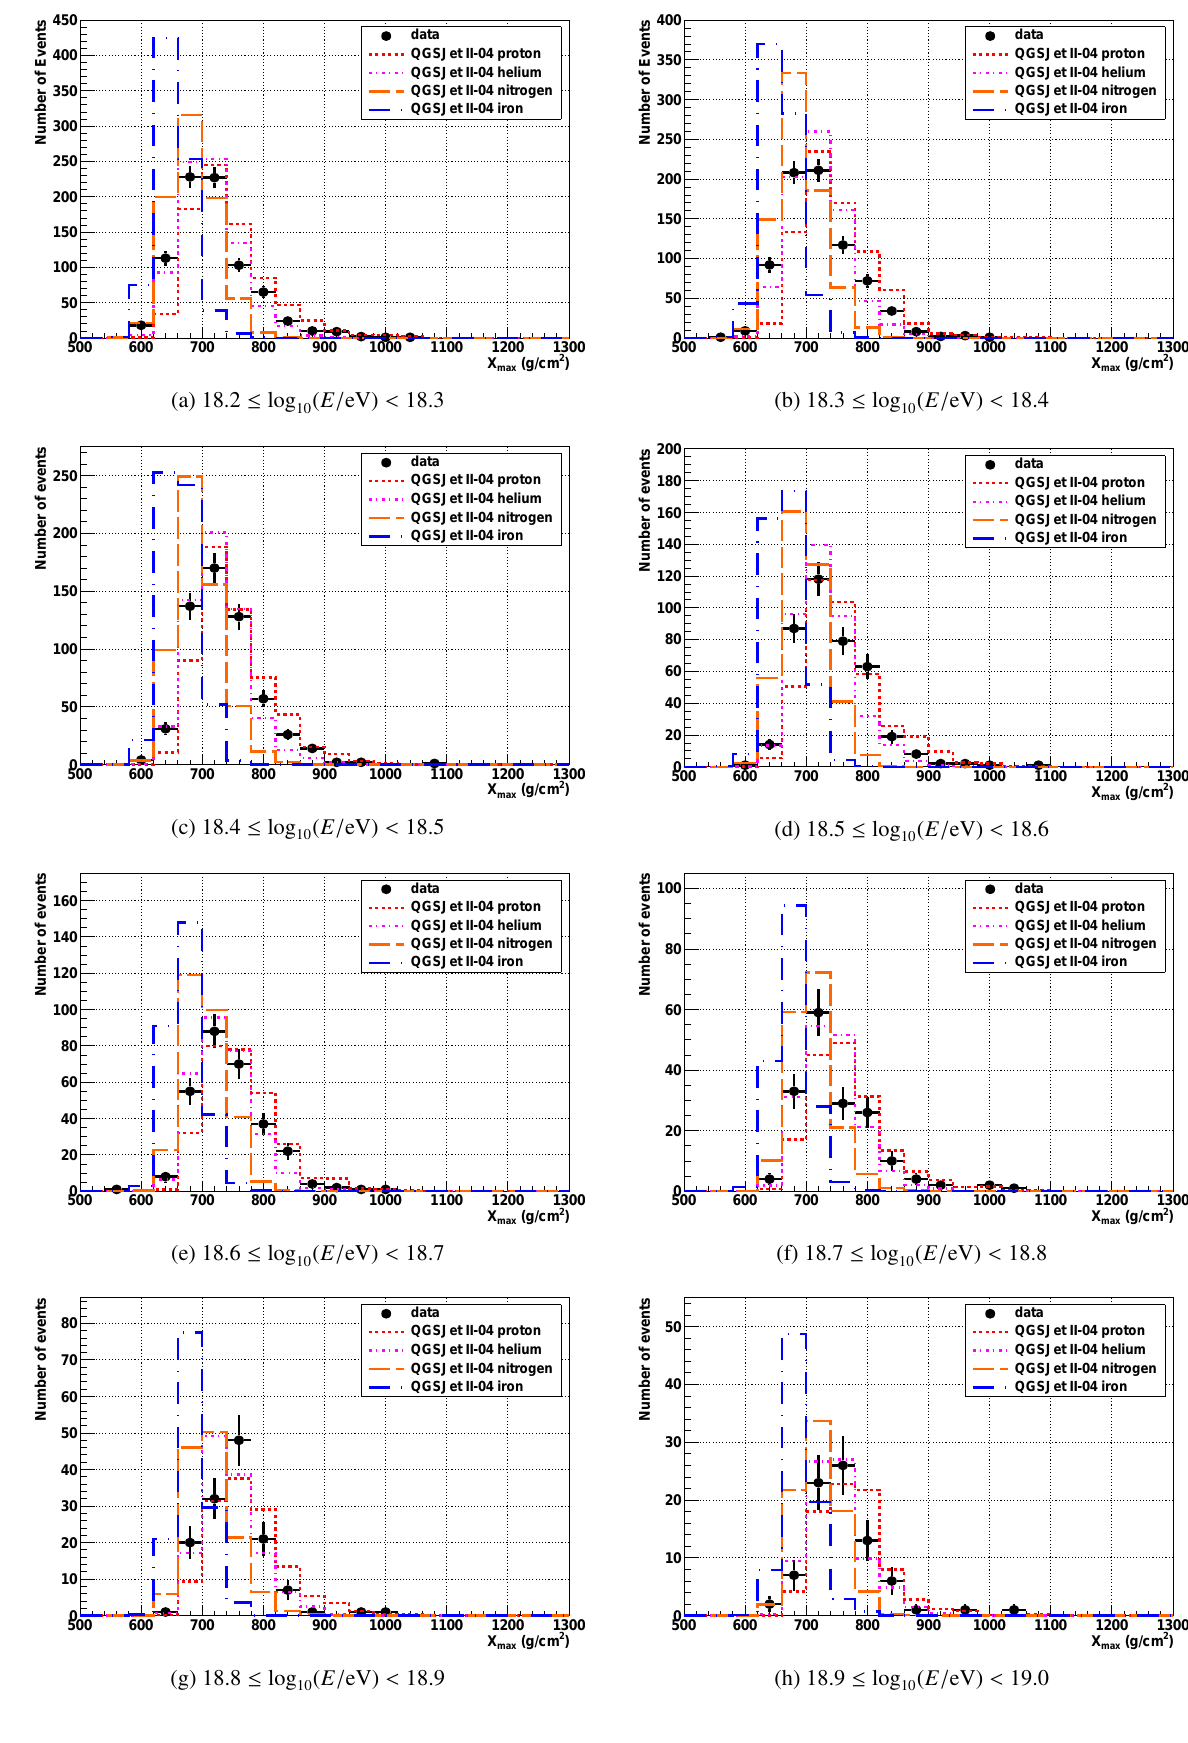
Figure 9: BR / LR hybrid X max distributions